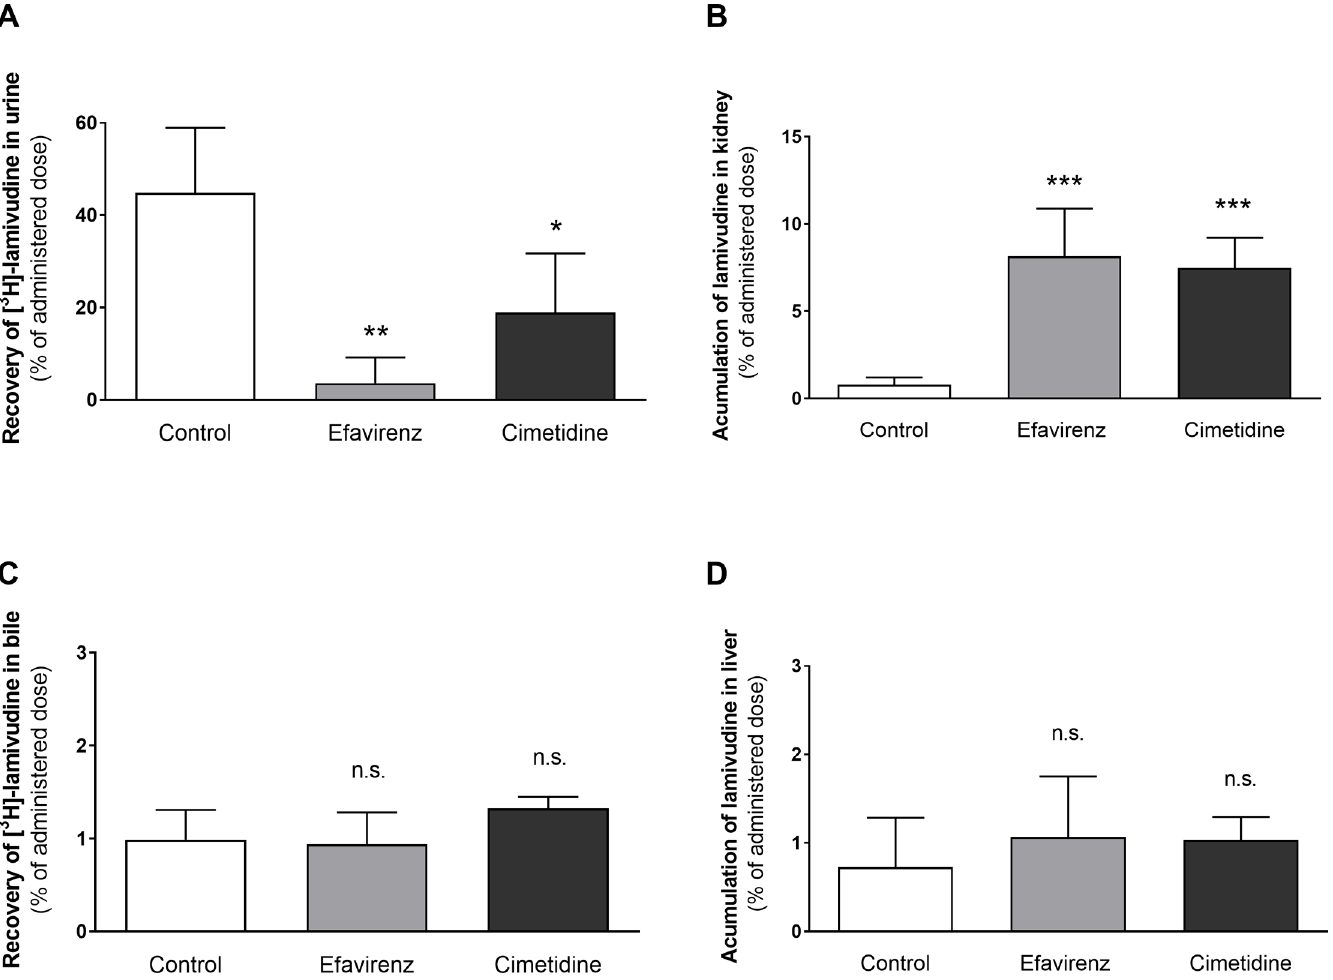
Fig 4. Total recovery of [ 3 H]-lamivudine from urine (A) and bile (C), and its accumulation in renal (B) and liver (D) tissue at 240 minutes after i.v. administration with or without co-administration of efavirenz (2.53 mg/kg) or cimetidine (a control inhibitor of the OCT and MATE transporters; 60,6 mg/kg). Data are shown as means ± SD (n = 5) and were analysed using one-way ANOVA followed by Dunnett‘s multiple comparison test (cid:3) P (cid:20) 0.05, (cid:3)(cid:3)(cid:3) P (cid:20) 0.001, n.s. not significant.